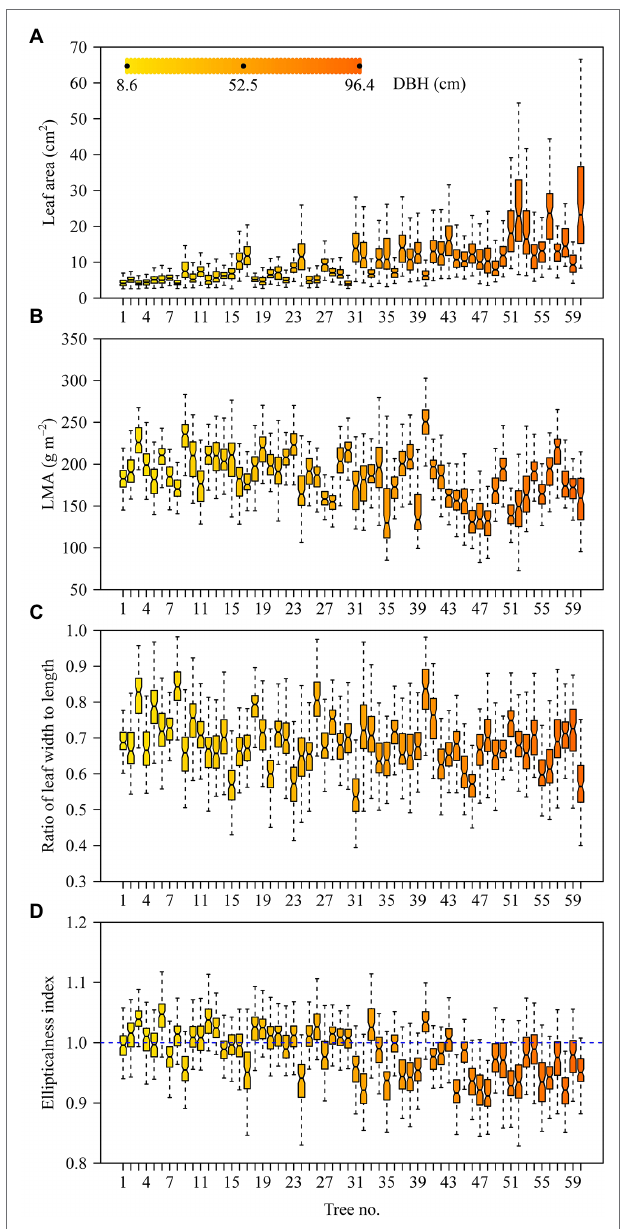
FIGURE 2 | Boxplots of leaf area (A) , leaf dry mass per unit area (B) , ratio of leaf width to length (C) , and leaf ellipticalness index (D) . The notches of boxes represent the medians, and the colors of boxes reflect their DBH values (see panel A ).